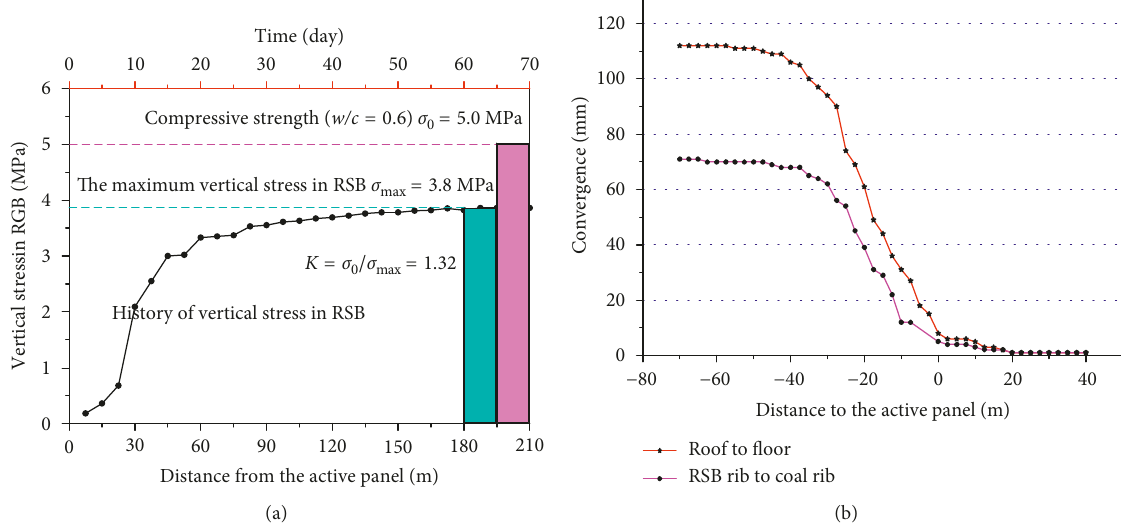
Figure 13: Monitoring result during advancement of the working face. (a) Vertical stress in RSB. (b) Roadway deformation